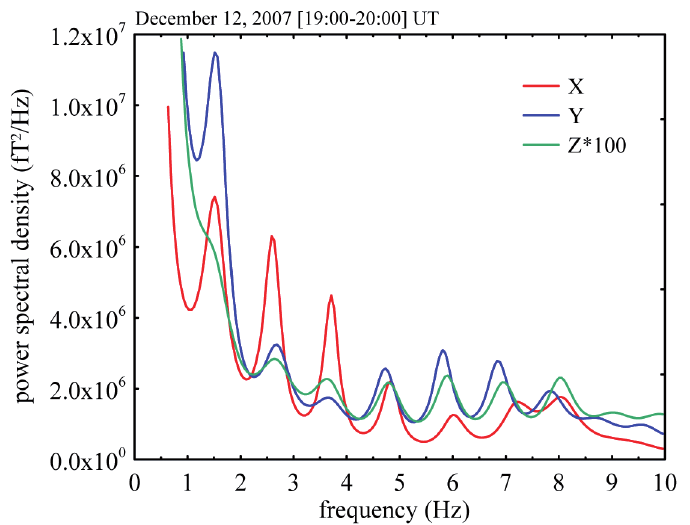
Fig. 9. An example of the spectral resonance structures of IAR. The frequency interval between the peaks is about 1Hz . For clarity the values of the Z component are multiplied by